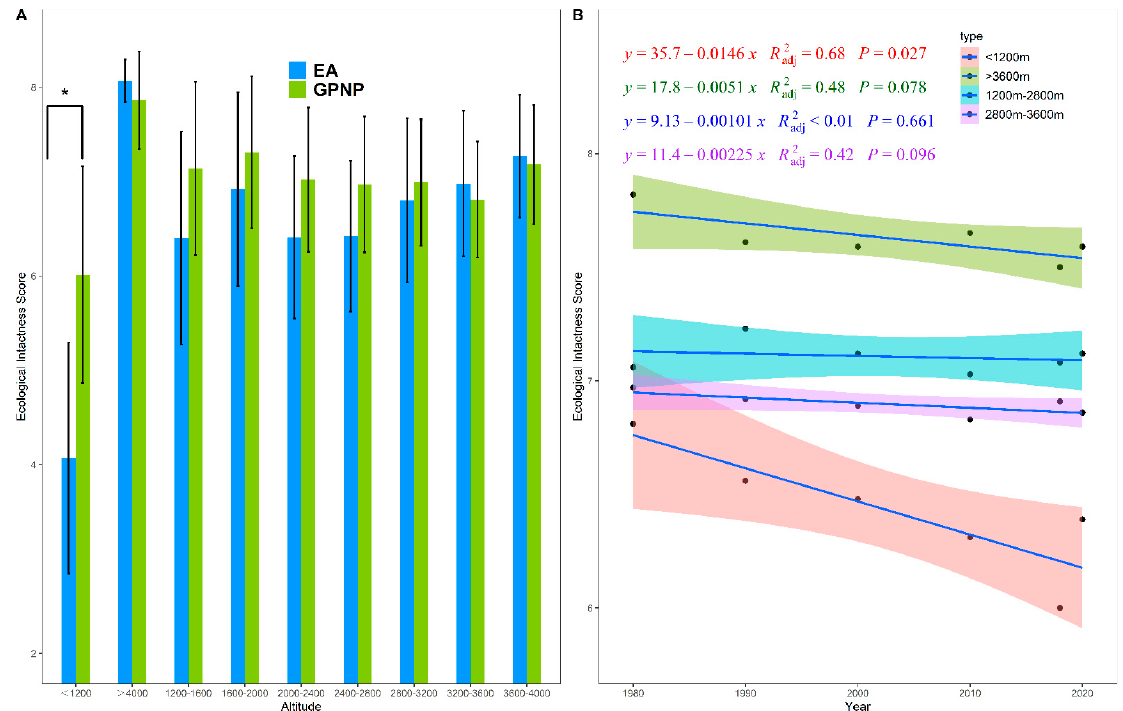
Figure 5. Ecological intactness score of different elevations between the GPNP and exterior areas (EA) for 2018 ( A ) and 40 years time-series dynamics for different elevations ( B ). * indicates a significant difference, and no mark indicates an insignificant difference.